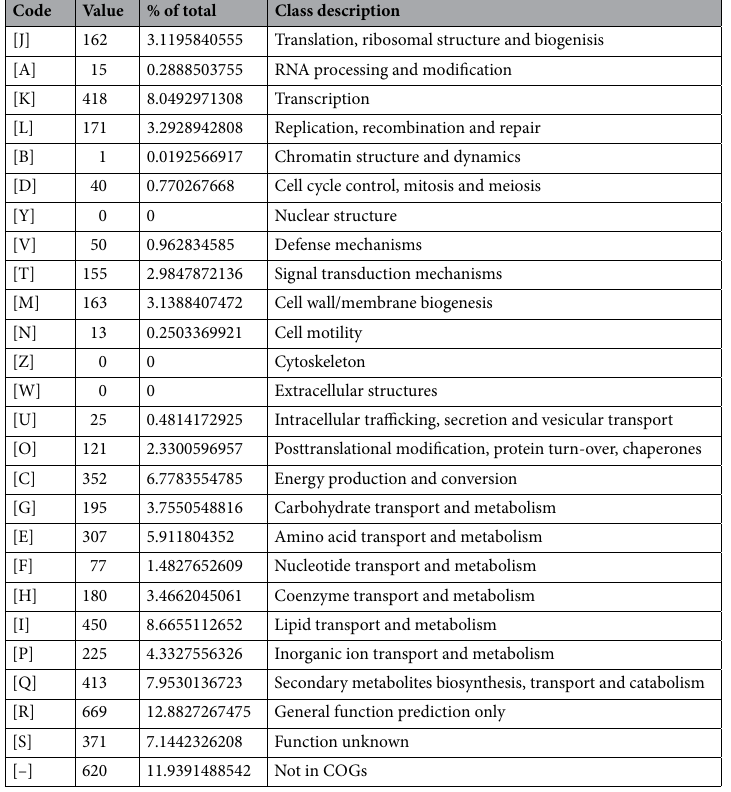
Table 2. Number and proportion of genes associated with the 25 general COG functional categories.